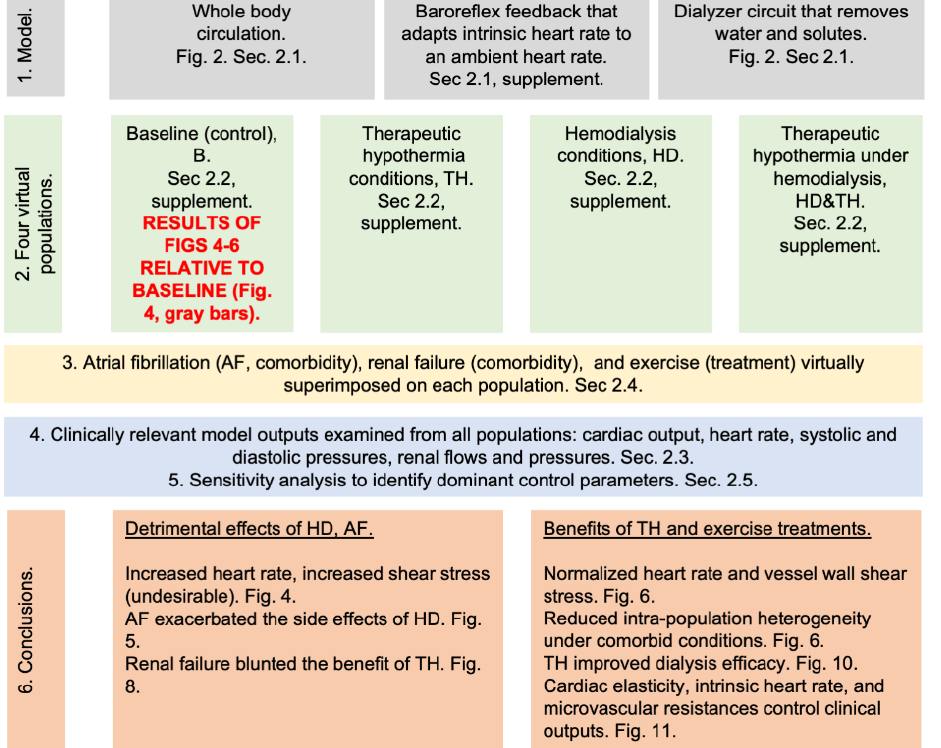
Figure 1. Block diagram summary of the presented work with sign posting to relevant sections.